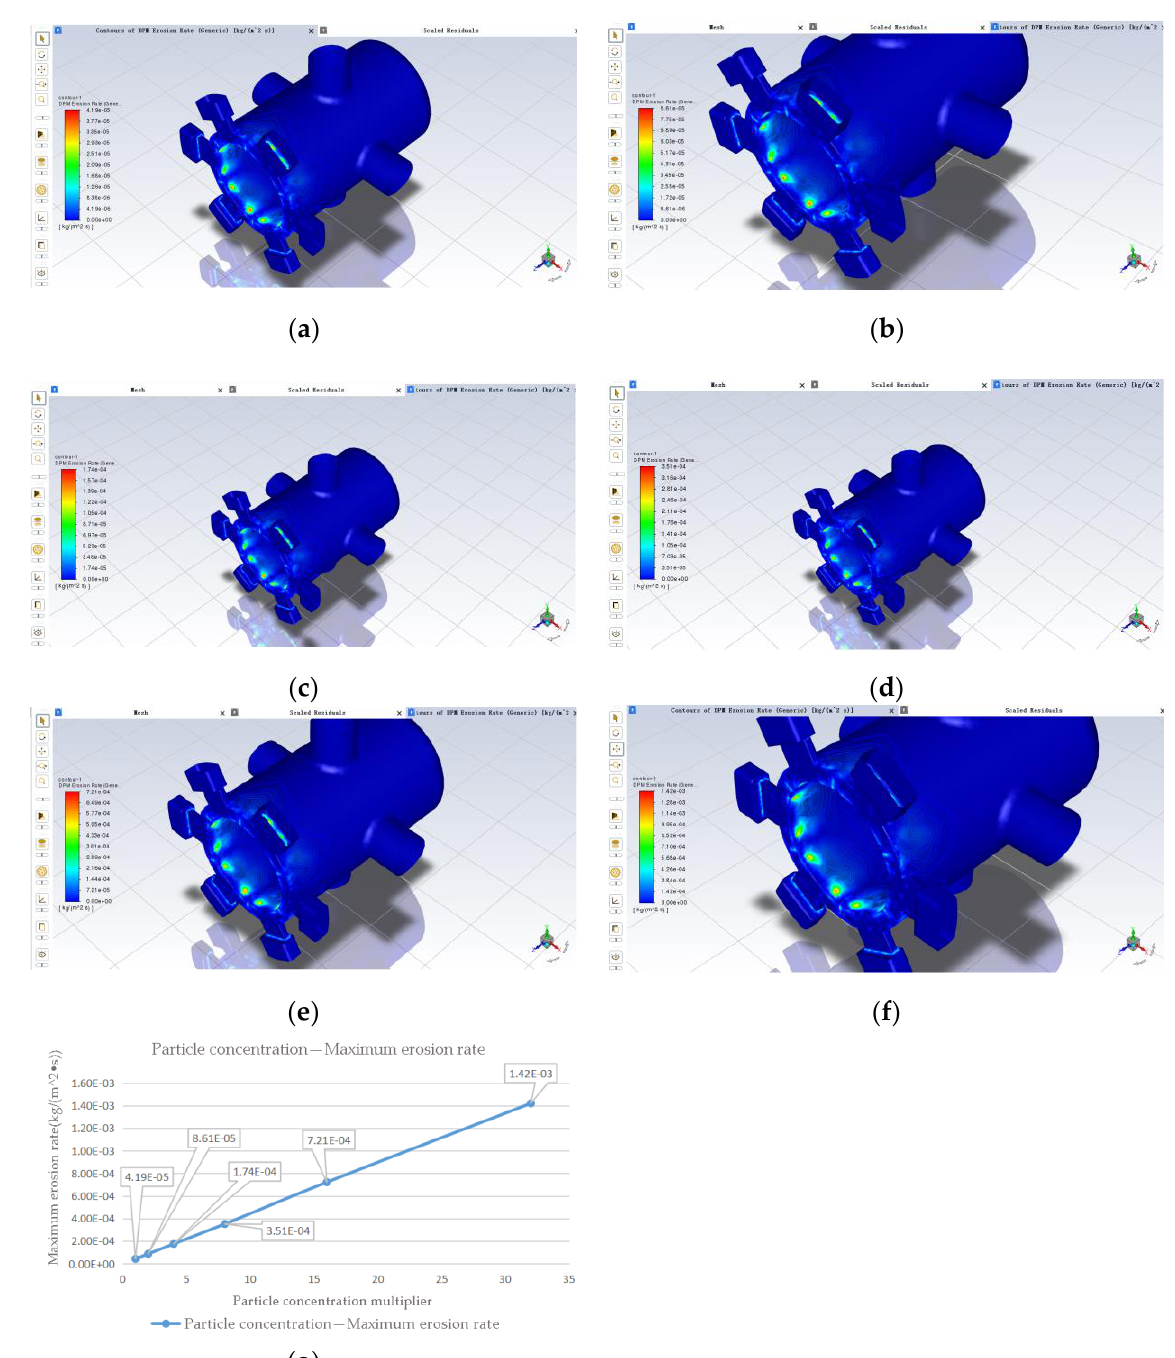
Figure 9. Effect of particle concentration on erosion rates: ( a ) original particle concentration; ( b ) 2 times particle concentration; ( c ) 4× particle concentration; ( d ) 8× particle concentration; ( e ) 16× particle concentration; ( f ) 32× particle concentration; ( g ) variation of maximum erosion rate with increasing particle concentration.